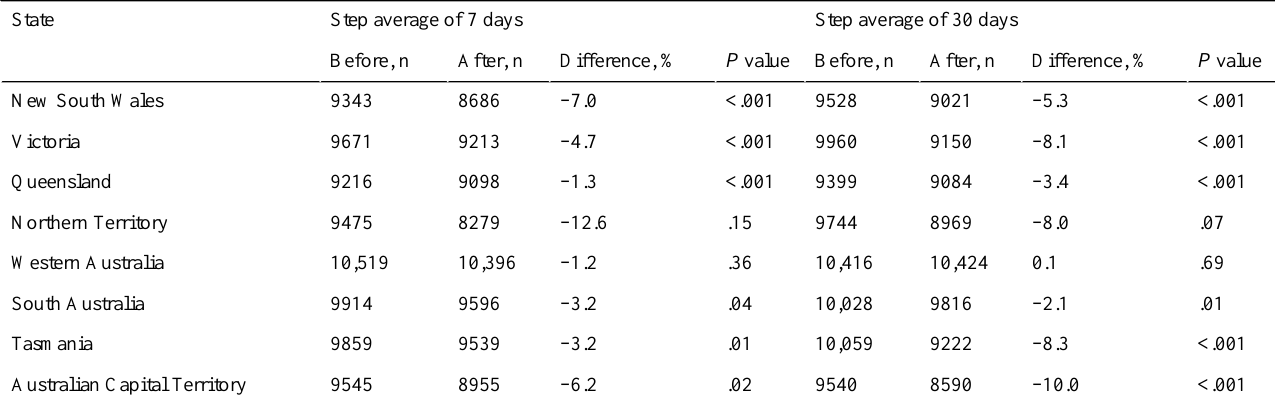
Table 3. Differences in step averages of 7 and 30 days before and after the start of the lockdown for each state.